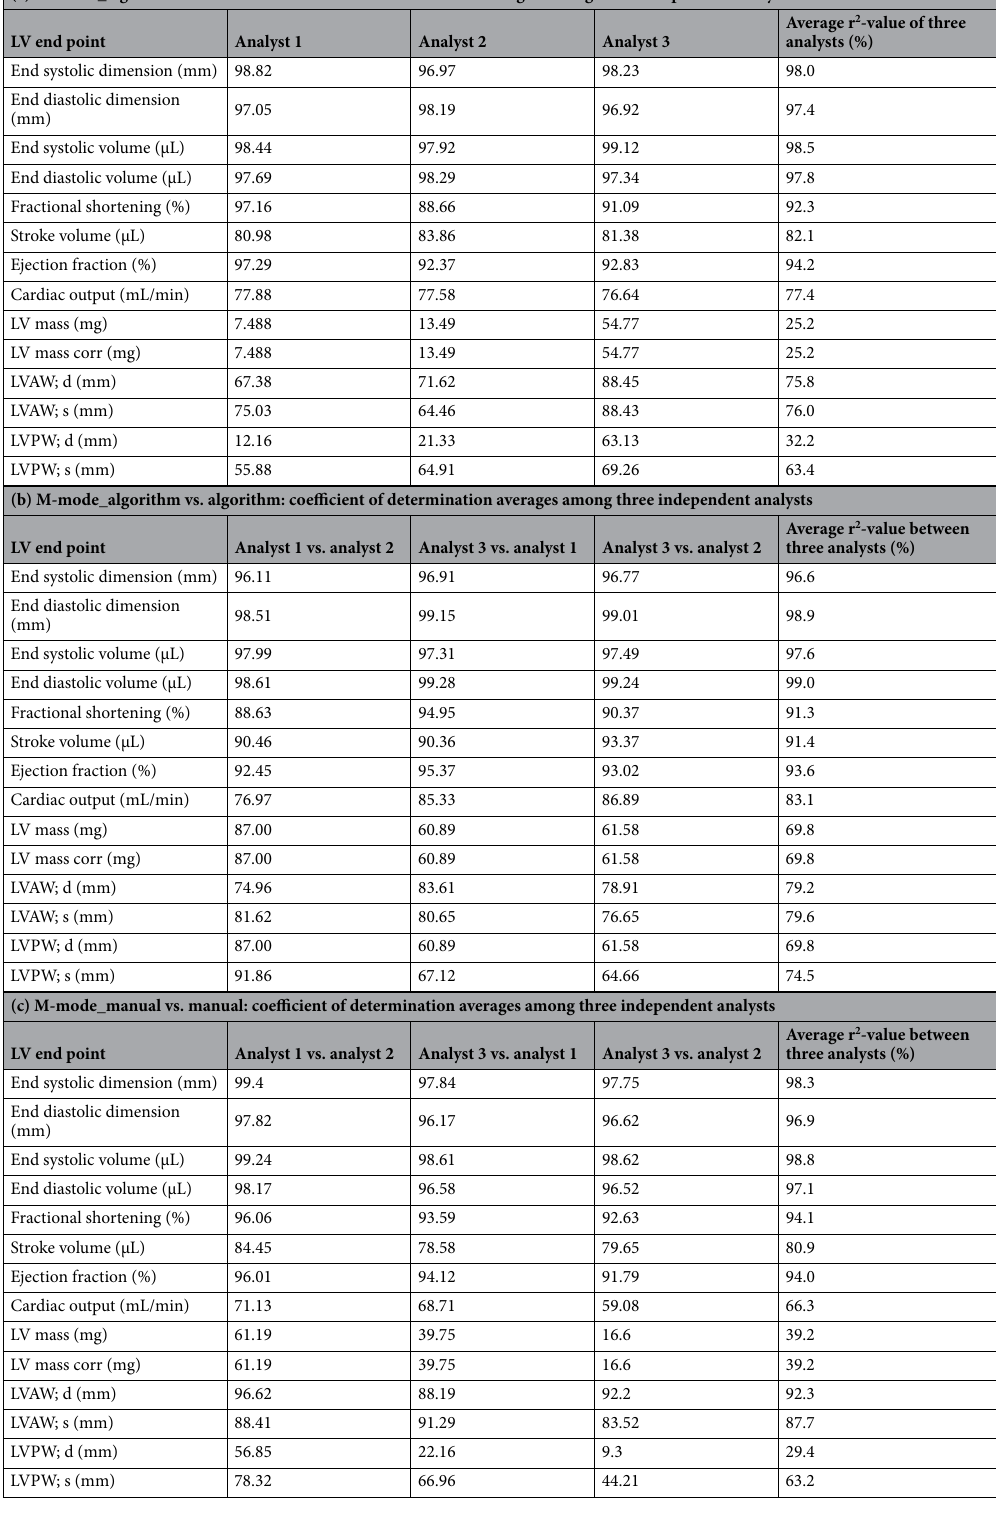
Table 2. Data tables of coefficient of determination averages amongst the three independent analysts for short axis M-mode left ventricle functional and structural end points. (a) Compares average coefficient of determination for each analyst using the semi-automated segmentation algorithm compared to using the manual segmentation technique. (b) Compares within analyst coefficient of determination averages while using the semi-automated analysis algorithm. (c) Compares within analyst coefficient of determination averages when using manual